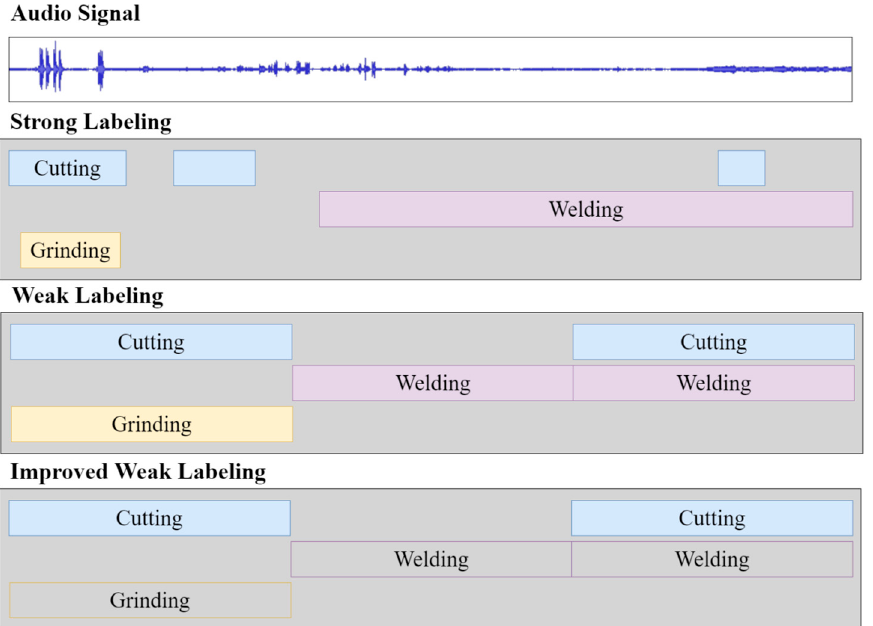
Figure 9. Data annotations of strong labeling, weak labeling, and improved weak labeling proposed in this research.